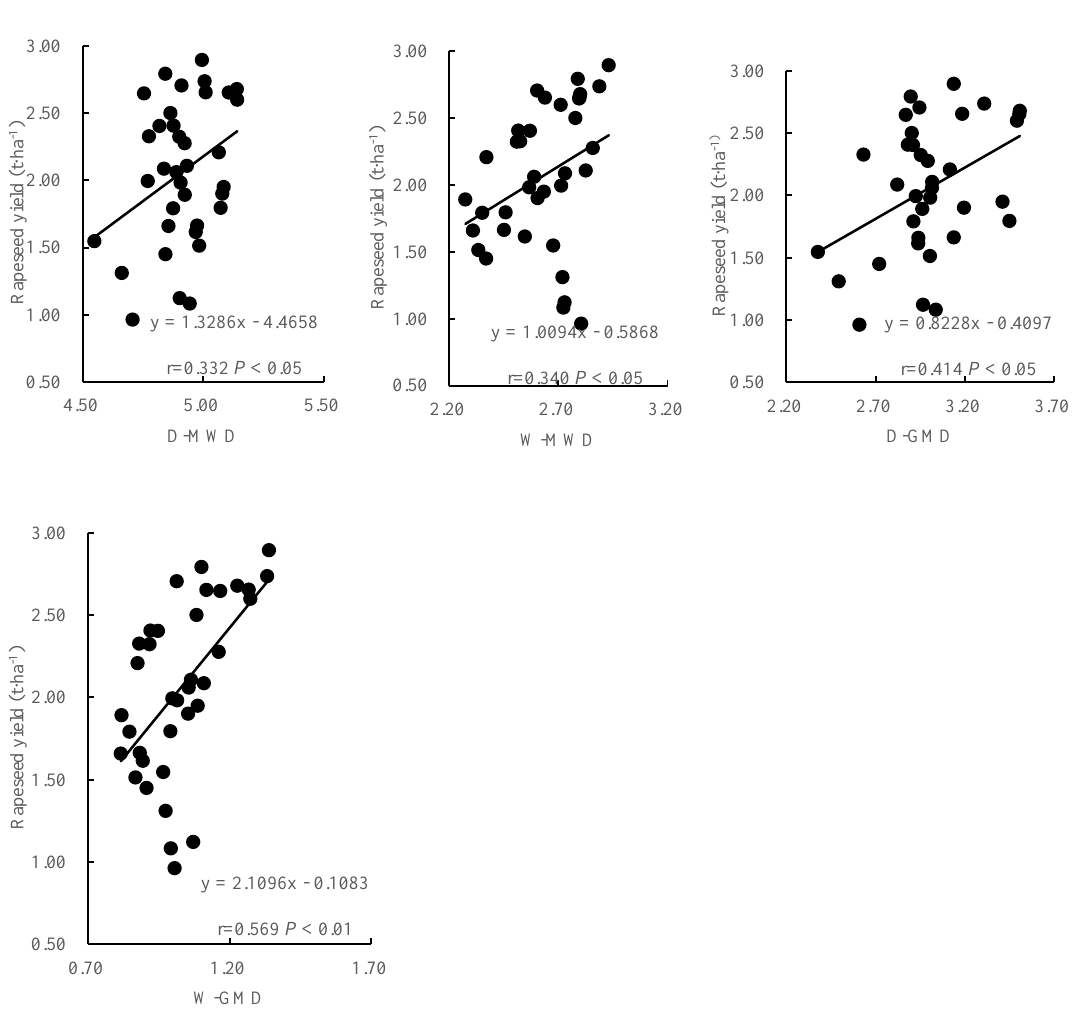
Figure 3. Relationship between soil aggregate index and rapeseed yield WR 0.25 means content of >0.25 mm soil water-stable aggregates; DR 0.25 means content of >0.25 mm soil mechanical-stable aggregates; W-MWD means mean weight diameter of water-stable aggregates; D-MWD means mean weight diameter of mechanical-stable aggregates; W-GMD means geometric mean diameter of water-stable aggregates; D-GMD means geometric mean diameter of mechanical-stable aggregates and PAD 0.25 means >0.25 mm percentage of aggregate destruction.